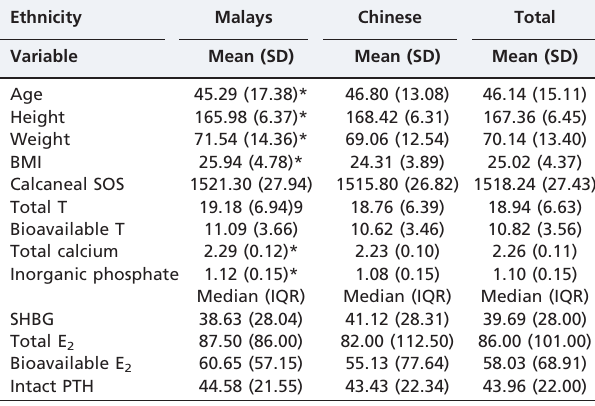
Table 1 - Characteristics of the study population, stratified by